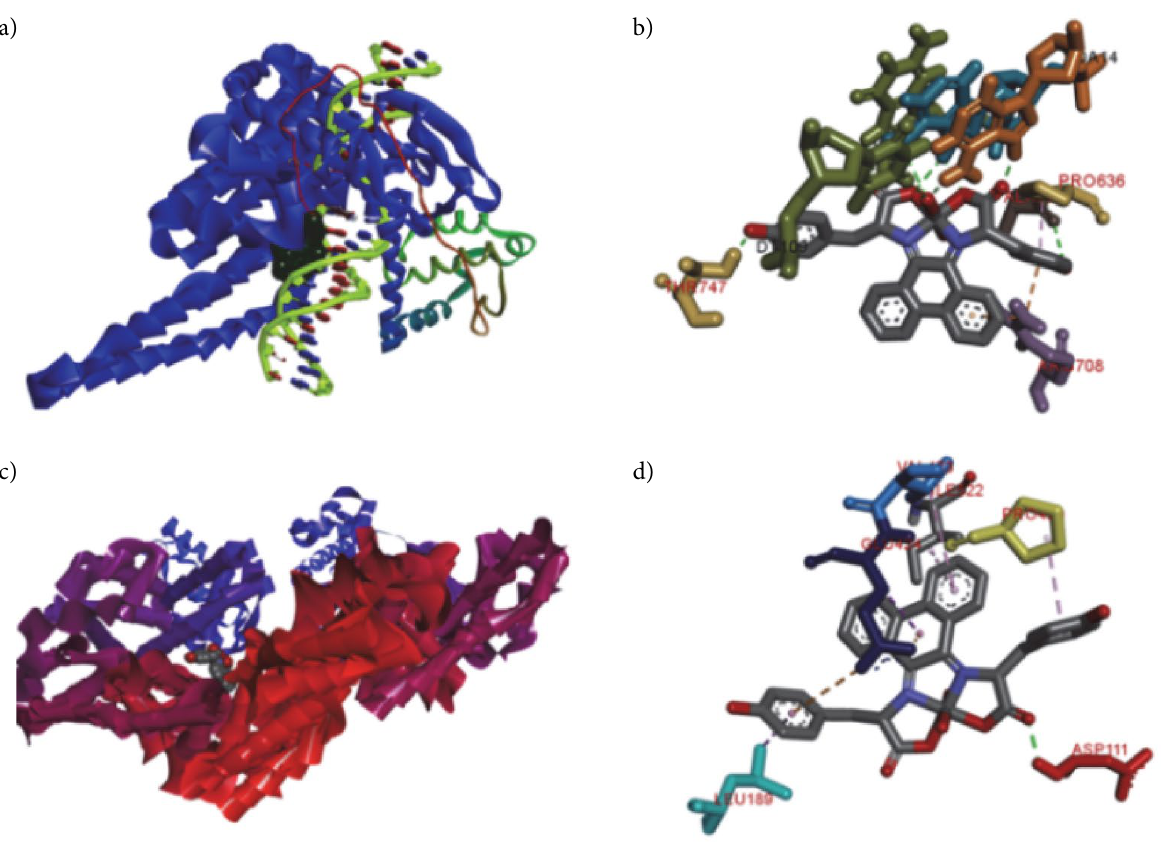
Fig. 10: (a) Molecular docked model of MnL with DNA. (b) specific interaction of MnL with DNA(c) Molecular docked model of MnL with BSA. (d) specific interaction of MnL with